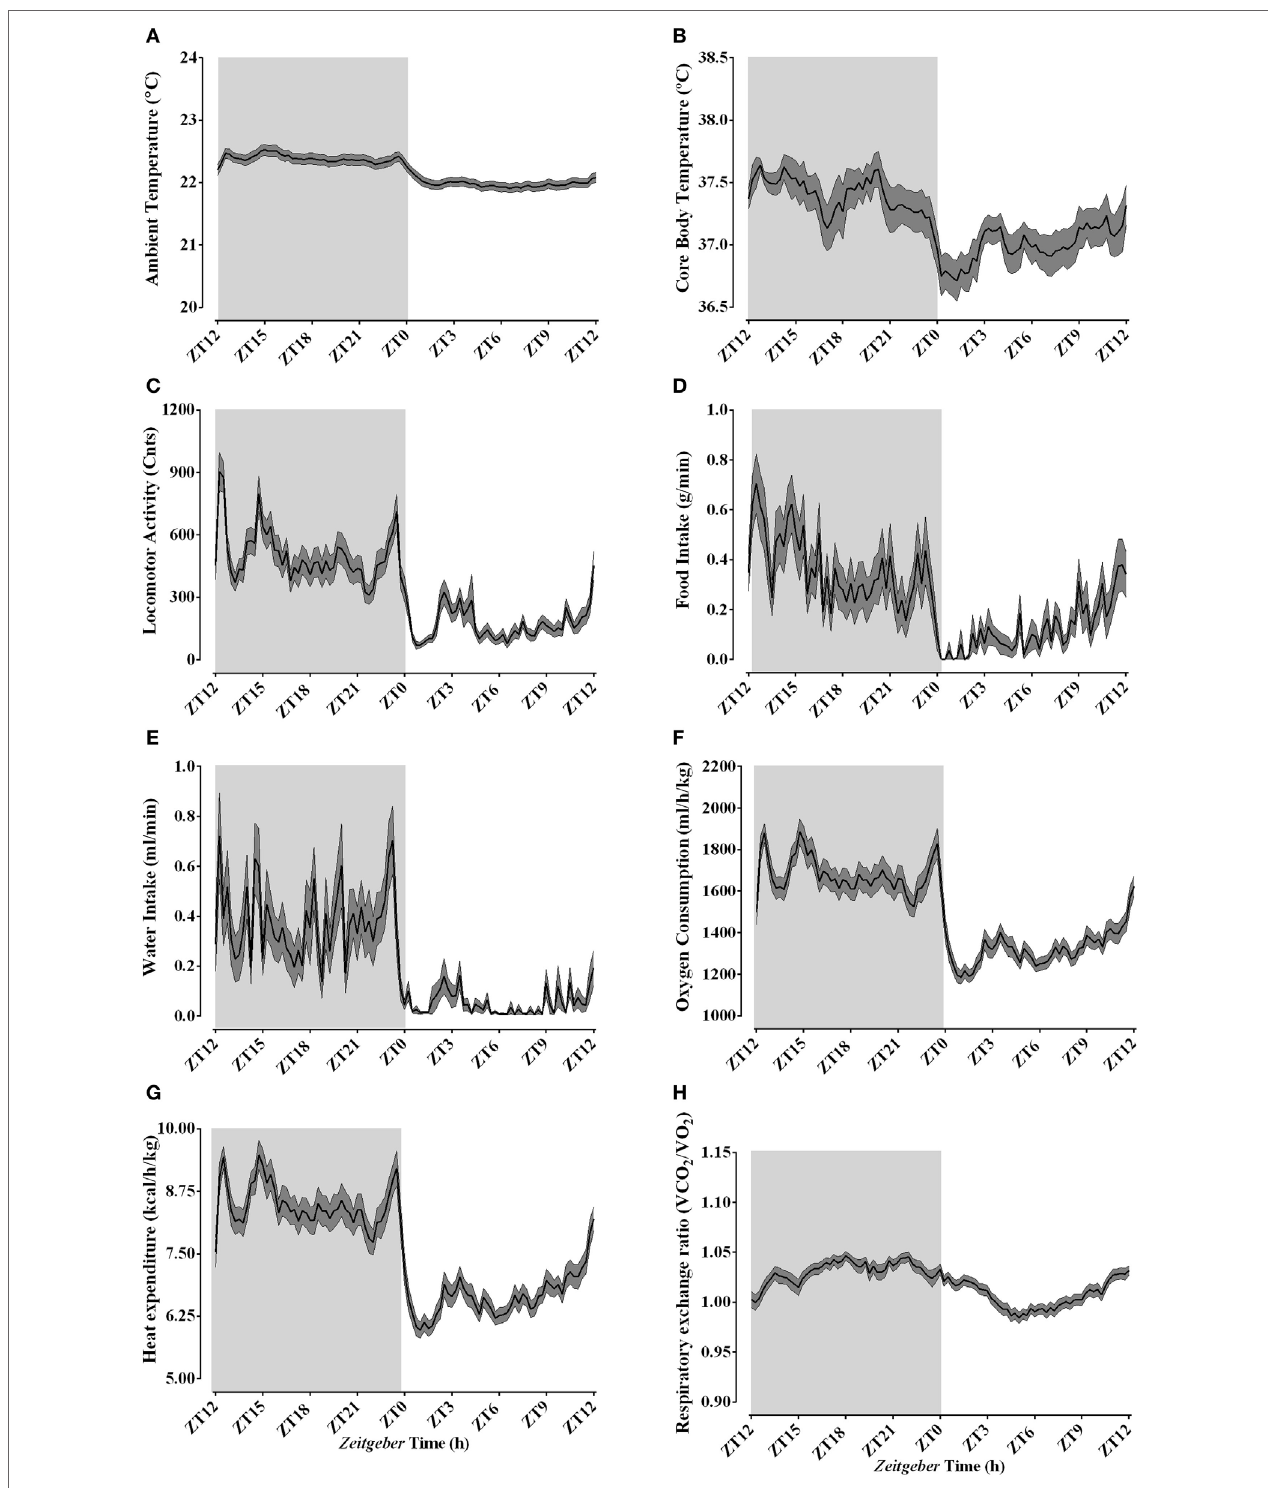
FigUre 2 | Daily rhythms of thermal, behavioral, and metabolic parameters under regular animal facility conditions. Light phase begins at Zeitgeber Time 0 (ZT0) and dark phase (shaded areas) begins at ZT12. Regular daily oscillatory levels of the ambient temperature (a) , body temperature (B) , locomotor activity (c) , food intake (D) , water intake (e) , oxygen consumption (F) , heat production (g) , and respiratory quotient (h) were monitored approximately 24 h before the cold episodes. Results are presented as mean ± SEM ( n =